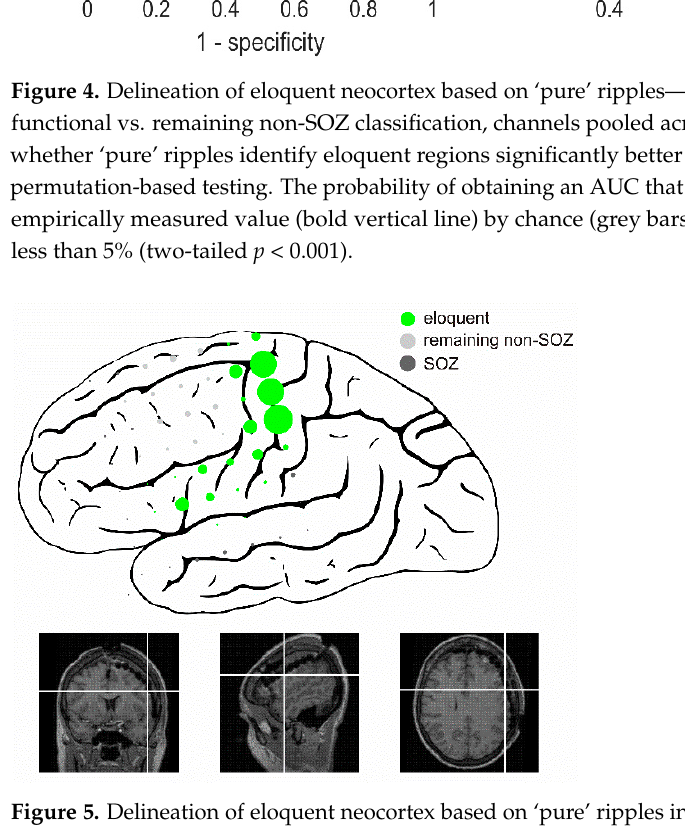
Figure 5. Delineation of eloquent neocortex based on ‘pure’ ripples in patient 9. Schematic illustrates approximate location of grid electrodes, MRI sections below are displayed for reference. Each filled circle represents one bipolar channel, with its radius proportional to its ‘pure’ ripple rate. Note that ‘pure’ ripples were particularly frequent in clearly functional neocortex, identified based on electrical stimulation. In this patient, these regions correspond nicely to the typical location of Broca’s area, primary motor and sensory cortex.